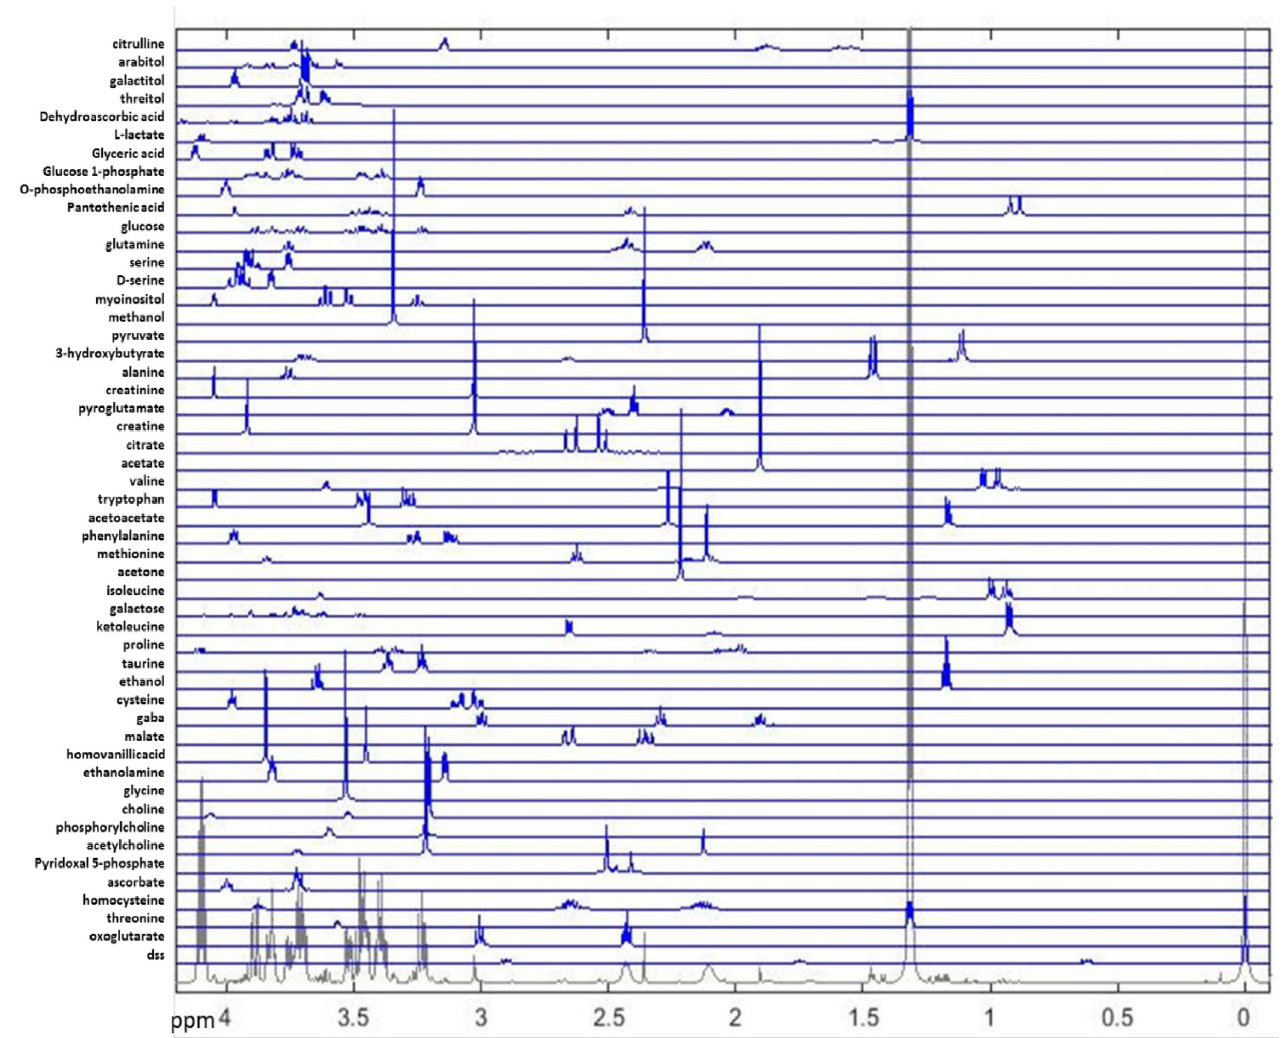
Fig 3. Metabolites determined by ASICS [24] and Metabohunter [25] as possible observed in CSF and blood NMR. Shown are complete spectral regions used for metabolite